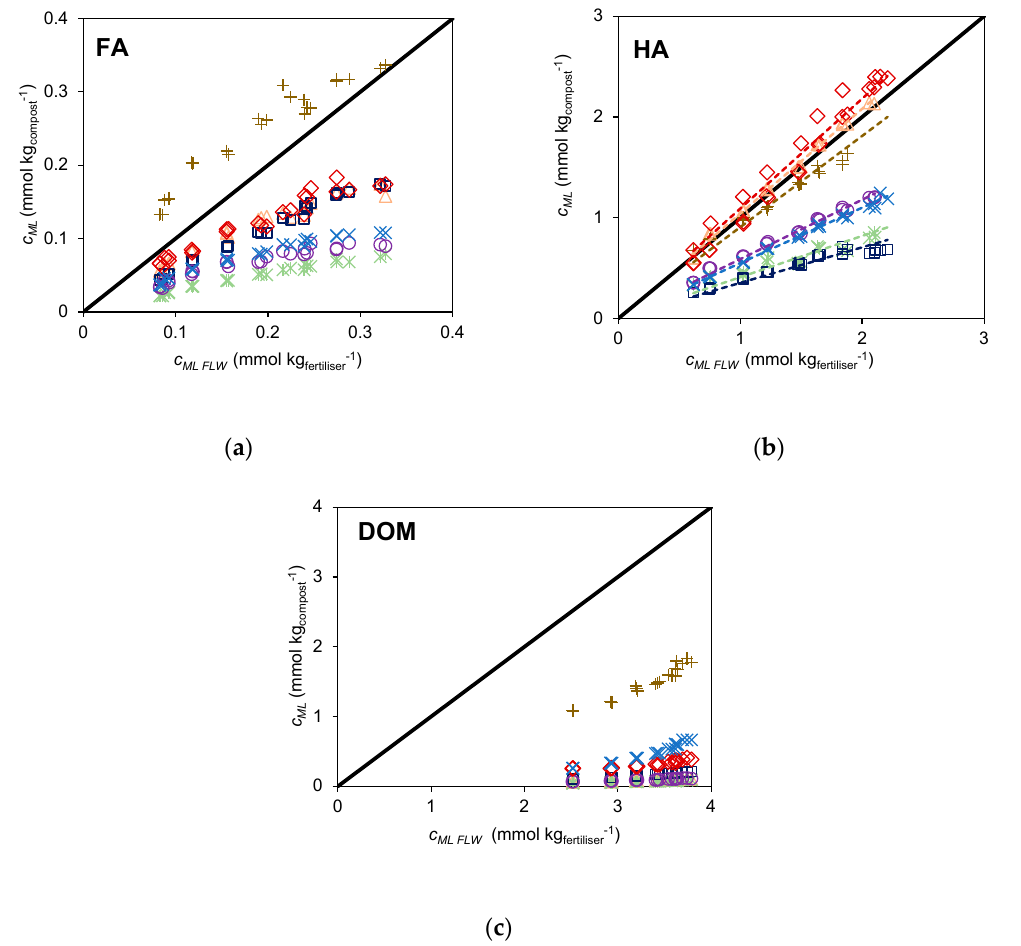
Figure 5. Comparison of Cd 2+ binding data of extracts obtained by samples of different origin (CDDW (purple ( )), CVDW (red ( ◇ )), CVA (green ( ∗ )), CA (coral ( (cid:52) )), CUW (blue ( × )), CSS (dark blue ( )), CLW (brown (+))) at pH 7.0 and 12 mmol L − 1 ionic strength: ( a ) FA extracts vs. FA-FLW, ( b ) HA extracts vs . HA-FLW and ( c ) DOM extracts vs . DOM-FLW. The y = x line represents the equivalence between results. The dotted lines in ( b ) correspond to the linear fit correlations. For the DOM extracts all points are well below the equivalence line (Figure 5c). CLW